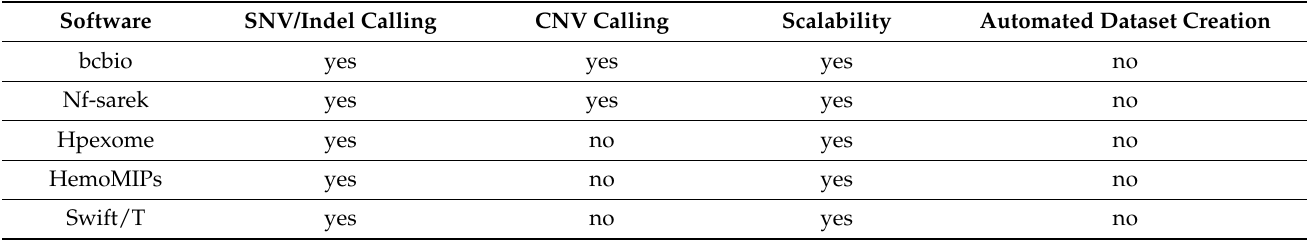
Table 3. Availability of SNV/CNV analysis automation in existing open-source software.